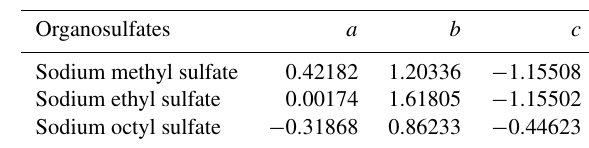
Table 3. The three coefficients ( a , b and c ) obtained by using Eq. (1) to fit RH-dependent GFs for sodium methyl sulfate, sodium ethyl sulfate and sodium octyl sulfate